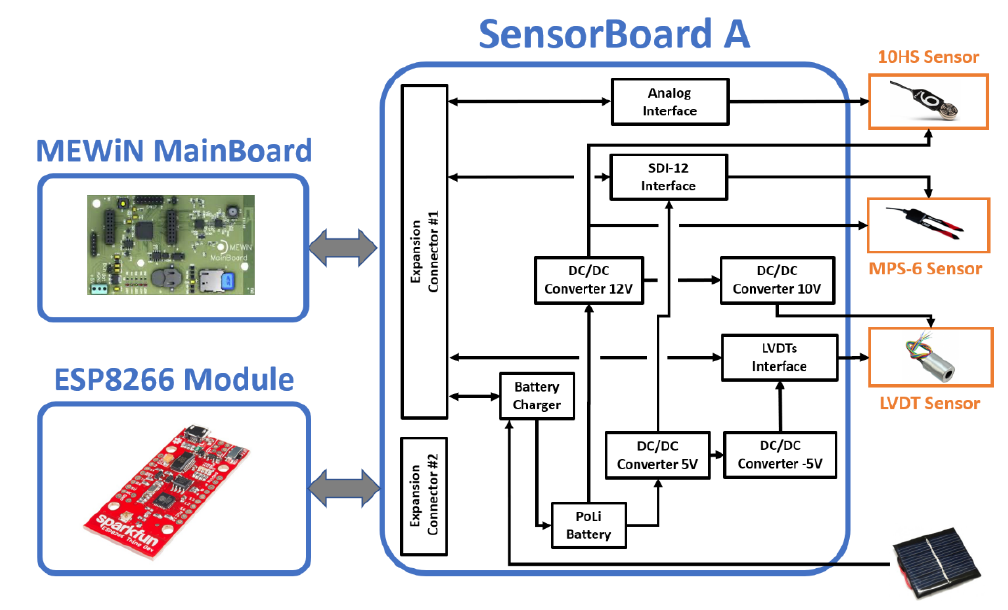
Figure 3. Block diagram of type-A node.